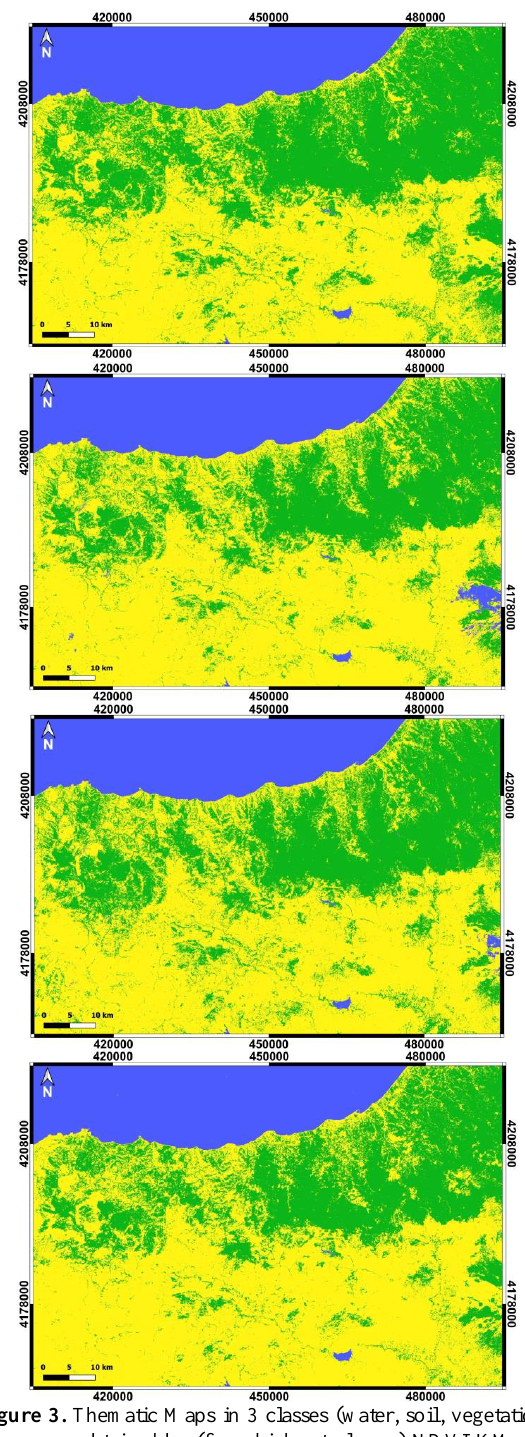
Figure 3. Thematic Maps in 3 classes (water, soil, vegetation), obtained by (from higher to lower) NDVI KM, RN KM, RGBN MD and 8MS